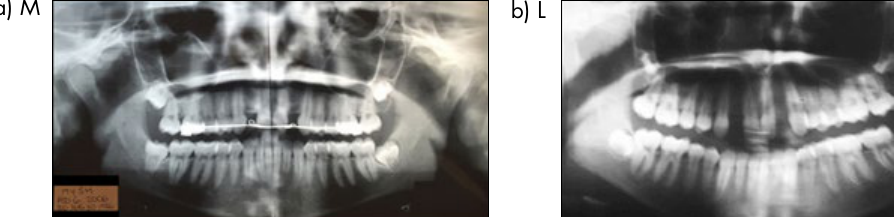
Figure 11. Post-treatment models.